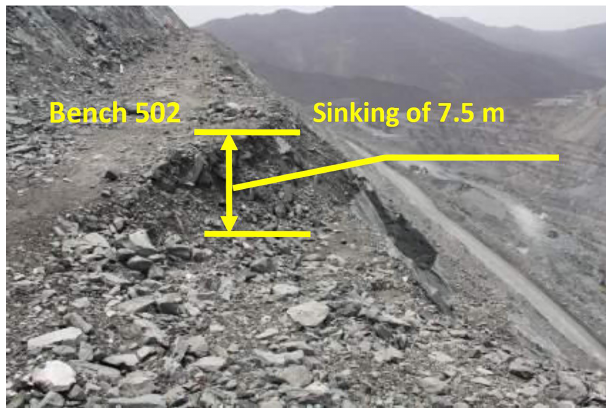
Figure 3. Sinking observed on the top of the slope.